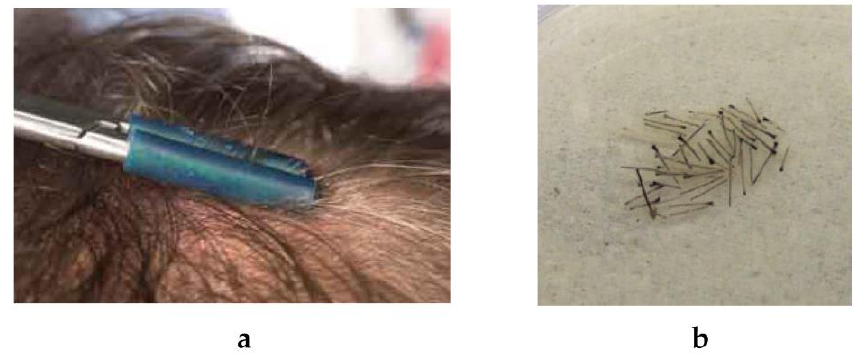
Figure 4. Preparation of hair follicles for the ATP measurements in the hair follicles: ( a ) hair pluck- ing; ( b ) separated hair follicles. ( b ) separated hair